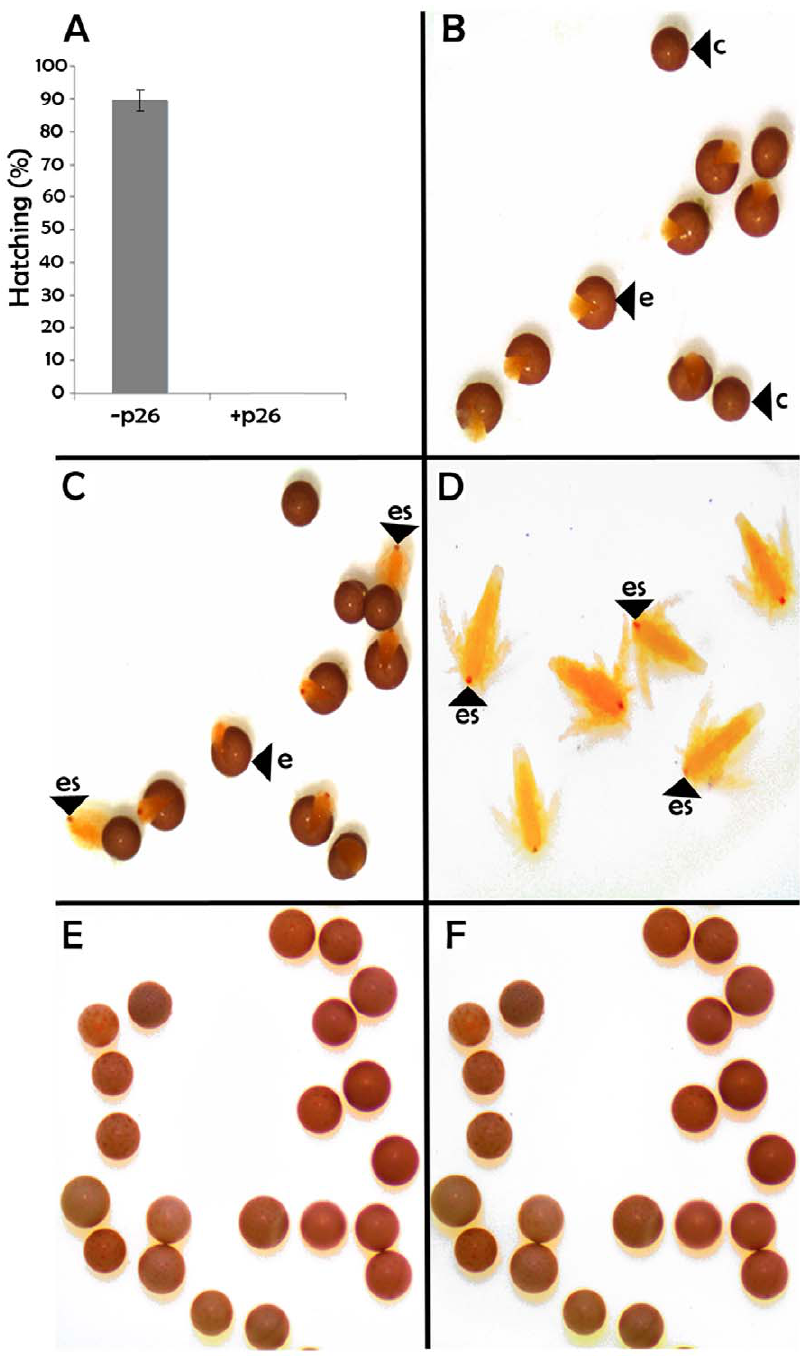
Figure 5. Artemia cysts lacking p26 terminate diapause spontaneously. A. Cysts lacking ( 2 p26) and containing ( + p26) p26 were incubated without agitation in sealed tubes for at least 90 days, transferred to weigh boats and observed with a dissecting microscope until 5 days after the last cyst hatched. The experiment was done in duplicate with different broods of cysts and the error bar represents standard error. B–F. Light micrographs showing the development, or absence thereof, for cysts lacking (B–D) and containing (E, F) p26. c, cyst; e, emerged cyst; es, eye spot. The nauplii shown in Fig. D originated from commercial cysts and they are representative of nauplii obtained from laboratory reared cysts lacking p26.